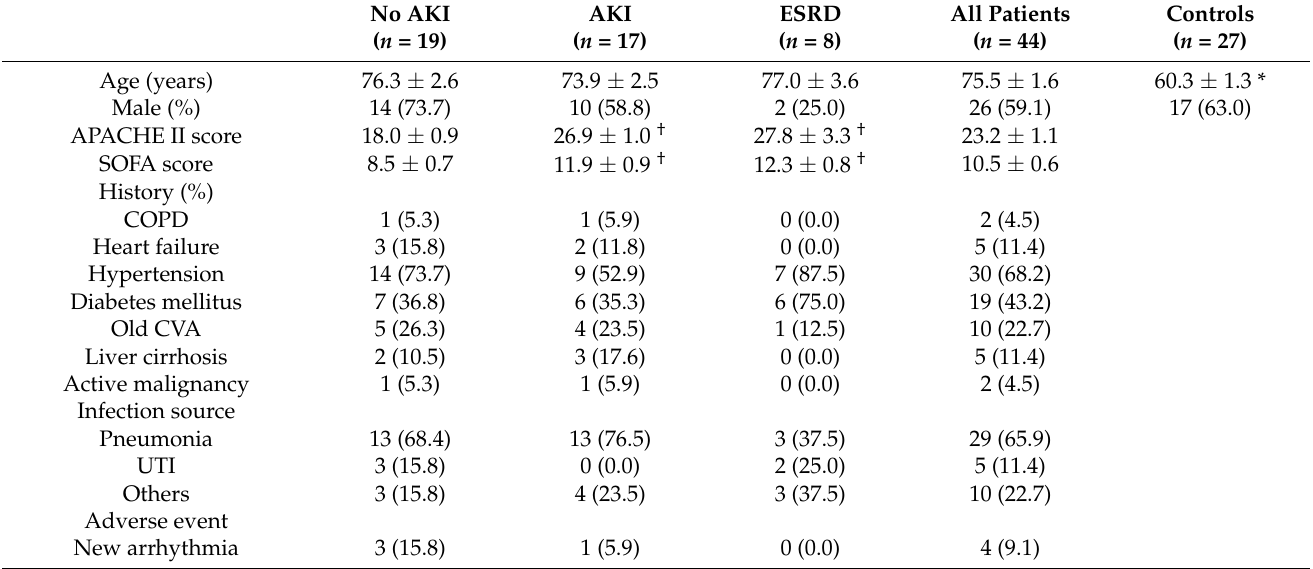
Table 1. Clinical characteristics in controls and patients with sepsis (number, mean ± standard error